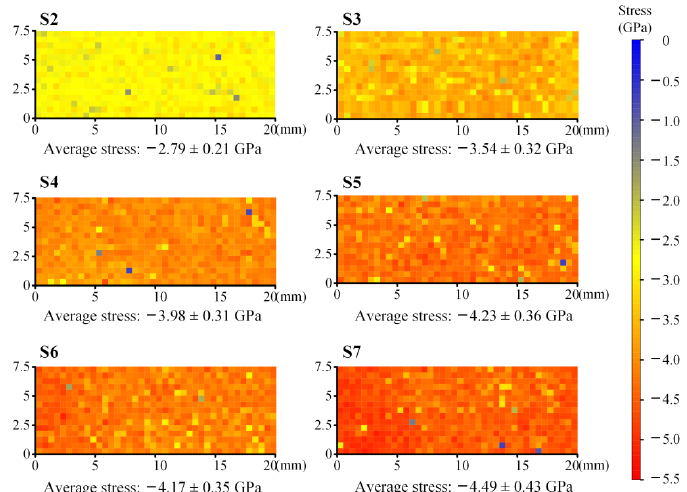
Figure 10. TGO stress fields of all specimens.